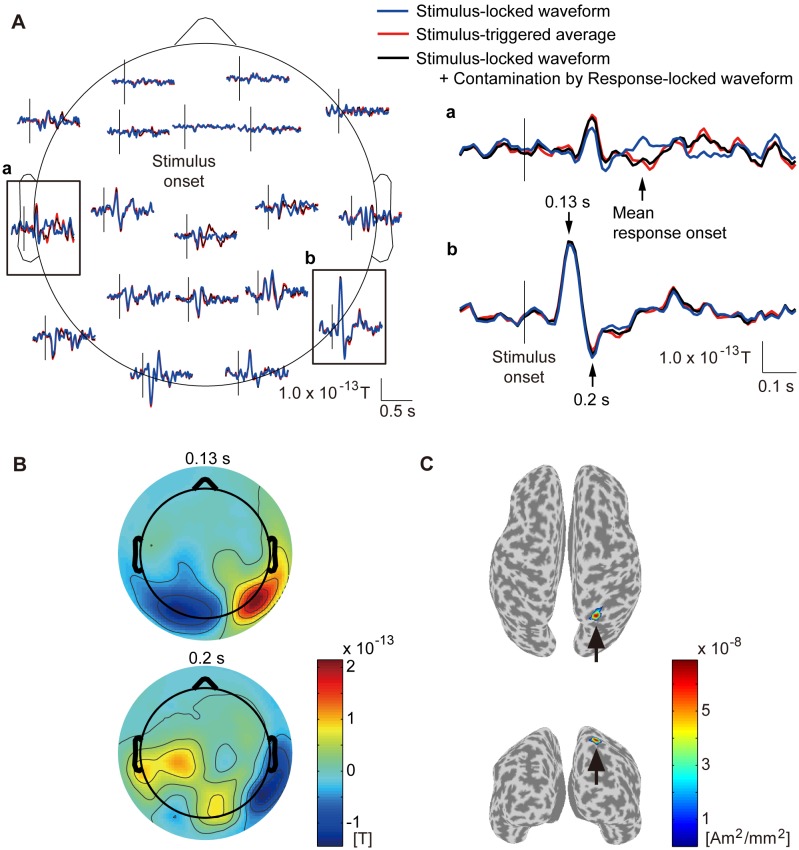
Stimulus-locked waveform (subject 8).
A: Time course of stimulus-locked waveform. Blue and red lines represent stimulus-locked waveform and stimulus-triggered average. Black lines represent stimulus-locked waveform contaminated by response-locked waveform. Vertical lines represent stimulus onset. Framed plots are enlarged on the right (a and b). B: Spatial patterns of stimulus-locked waveform at 0.13 s (upper) and 0.2 s (lower) after stimulus onset. C: Current sources estimated from stimulus-locked waveform. Powers averaged across time from 0 to 0.5 s after stimulus onset are shown. Other subjects show similar results.